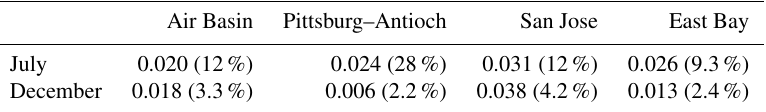
Table 3. Increase (ppb) in the formaldehyde emissions semi-normalized sensitivity of model responses resulting from turning off chemistry in the model. The numbers in parentheses indicate the magnitude of the increase relative to the original